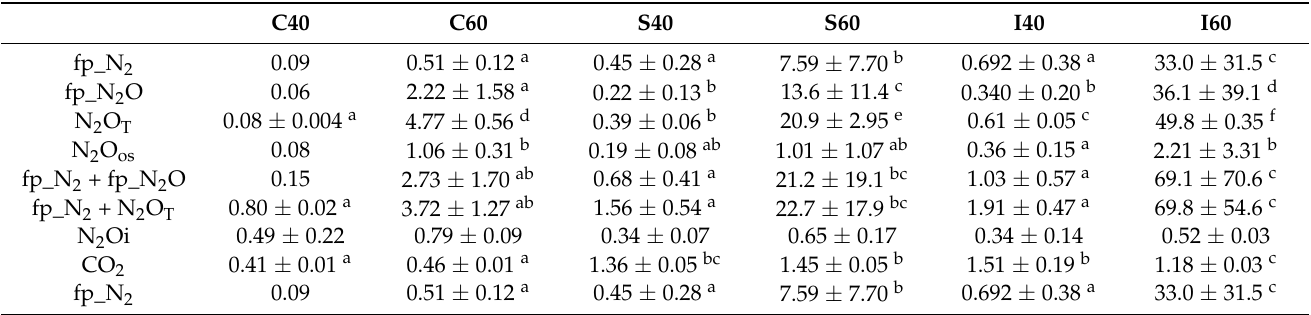
Table 4. Average daily fluxes of CO 2 , total N 2 O (N 2 O T ), of N 2 (fp_N 2 ) and N 2 O (fp_N 2 O)